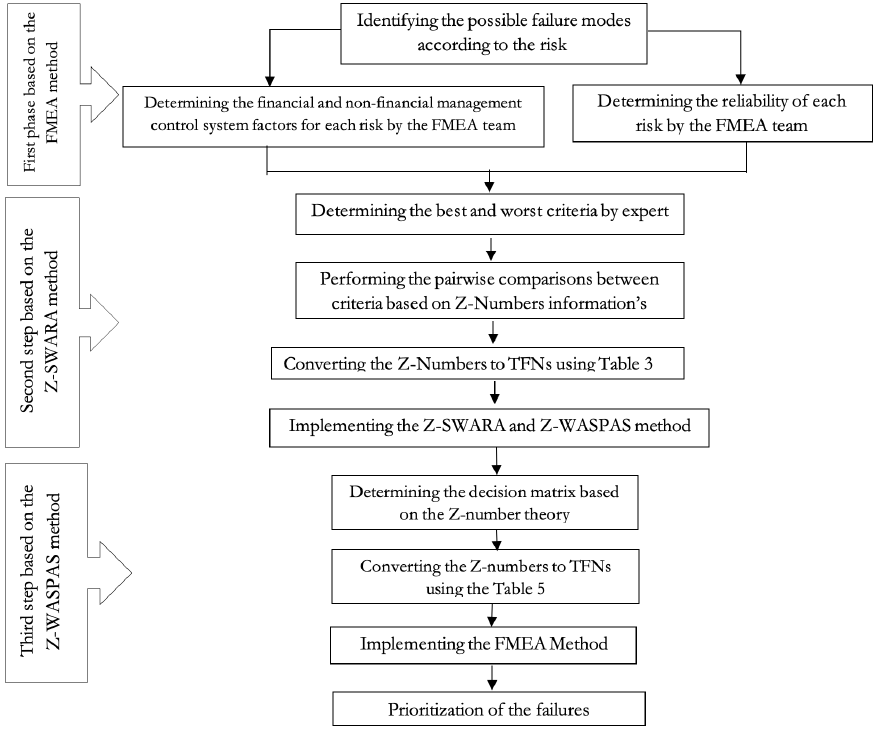
Figure 1. Assessment